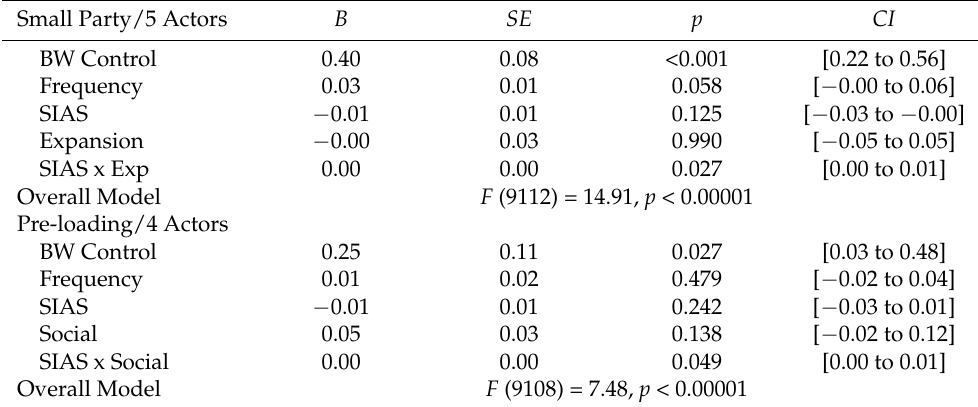
Table 3. Regression of behavioral willingness for cannabis on social anxiety, cannabis use motives, and interaction terms in the small party and pre-loading scenes when interactions were statistically